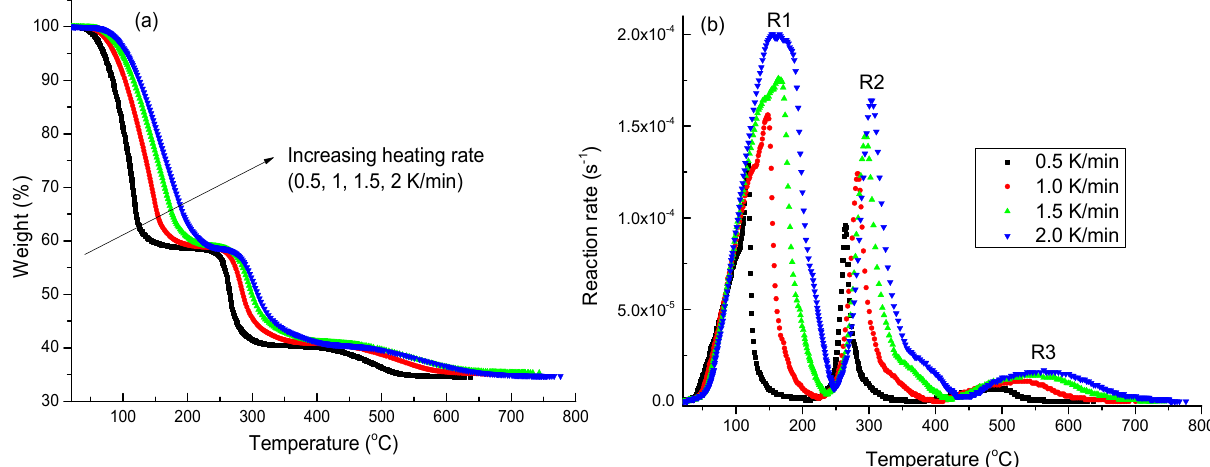
Figure 4. Weight changes of cation-exchange resin (CER) ( a ) and the reaction rates ( b ) determined by the nonisothermal TGAs with different heating rates of 0.5, 1.0, 1.5 and 2.0 K/min.